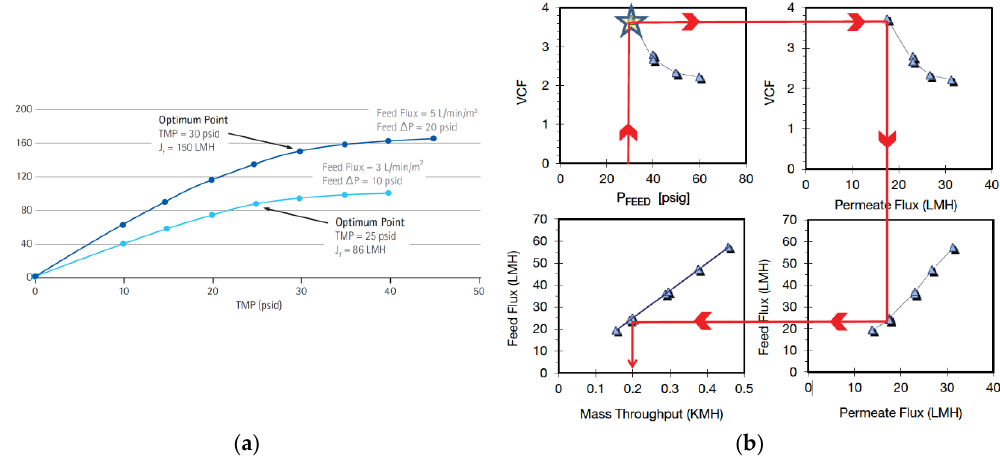
Figure 2. Commercial data: ( a ) determination of optimal process point reproduced with permission from Merck Millipore, 2012, ( b ) optimization strategy for SPTFF reproduced with permission from, Pall Corporation, 2014.